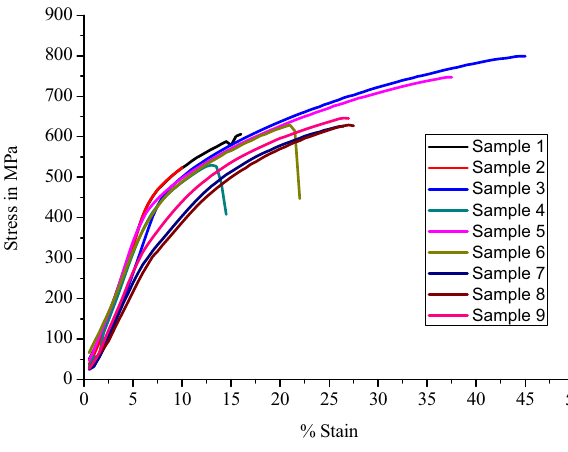
Figure 9: Stress – strain curves for various samples of Butt welds.